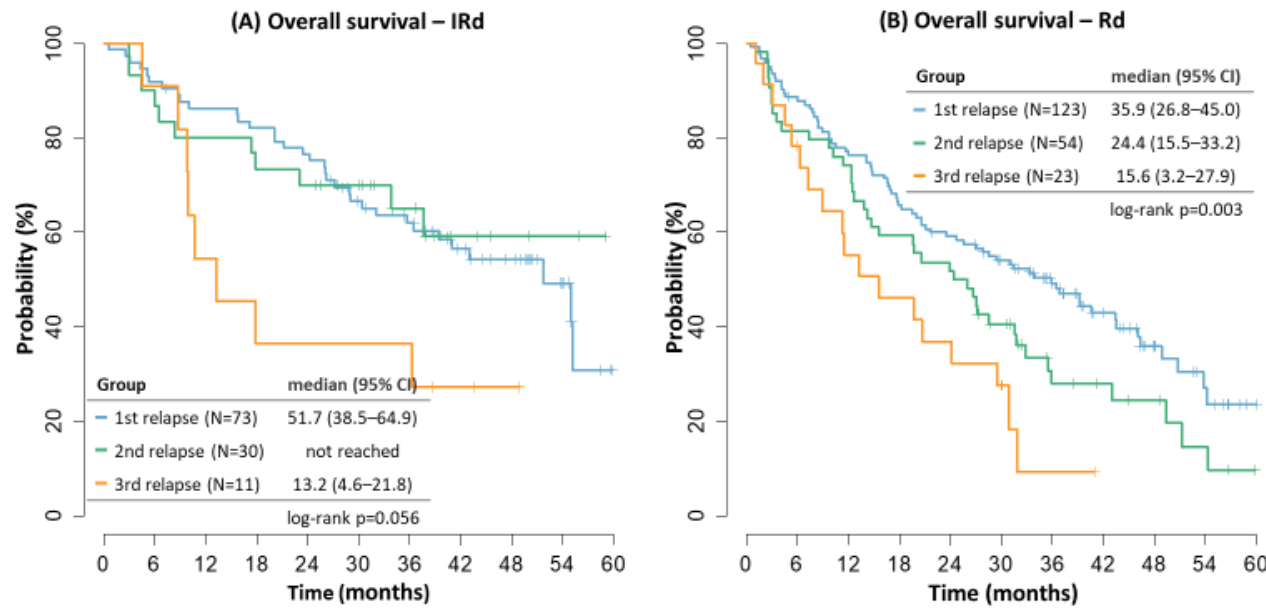
Figure 4. Overall survival by treatment line.